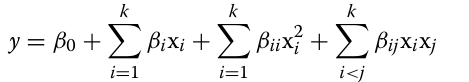
standard deviation ±